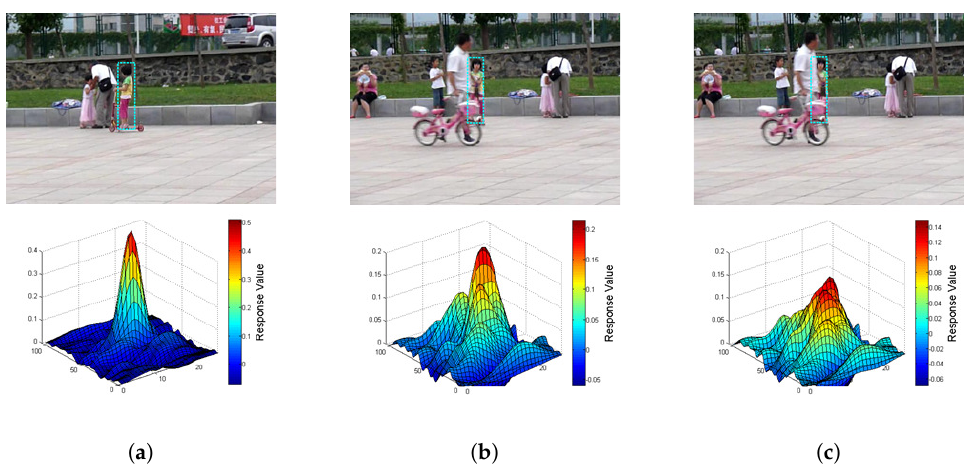
Figure 2. Illustration of the occlusion caused by a similar object in the girl2 sequence. The z -axis range of the response map is different, in order to clarify the value of the sidelobes in different occlusion states. ( a ) Non-occlusion target and its response map; ( b ) Slight occlusion target and its response map; ( c ) Heave occlusion target and its response